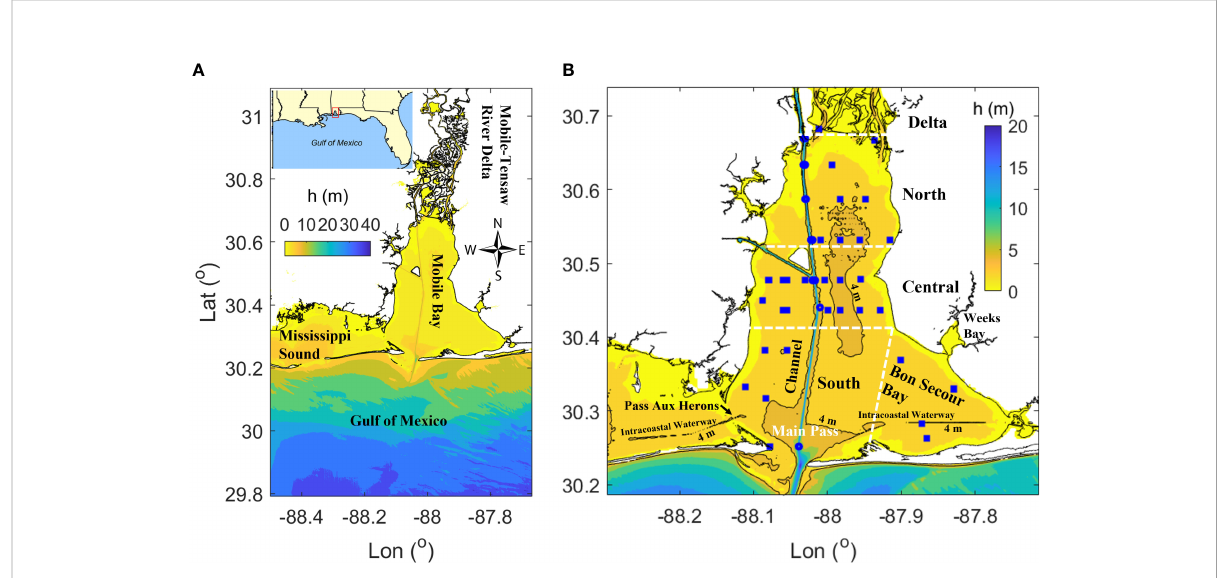
FIGURE 1 (A) Map of Mobile Bay. (B) Map of subregions in Mobile Bay and observed hypoxic locations for 2019. In (A, B) pseudo-color denote bathymetry. In (B) white dashed lines denote subregion boundaries and the tidal inlet at Main Pass. Narrow black regions down the middle of the bay represent the shipping channels. Narrow channels with 4 m depth in Bon Secour Bay and southwest of Pass Aux Herons are the Gulf Intracoastal Waterway. Blue squares denote all observed hypoxia locations from April to August 2019 (data from Coogan et al.,